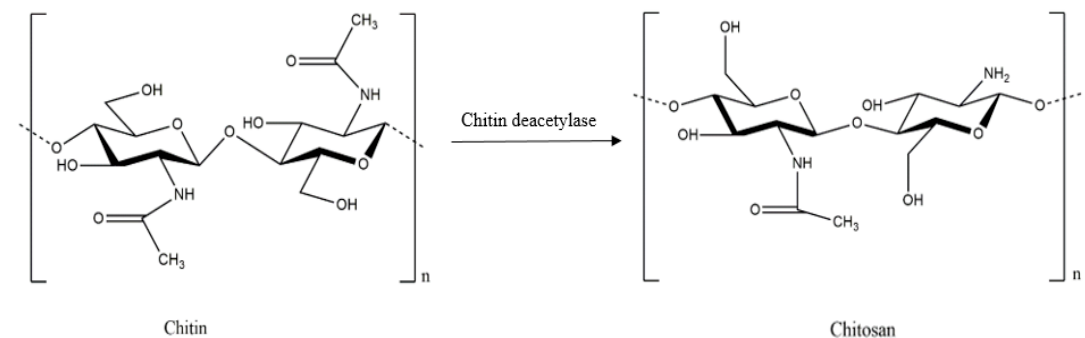
Figure 1. Structure of chitosan.